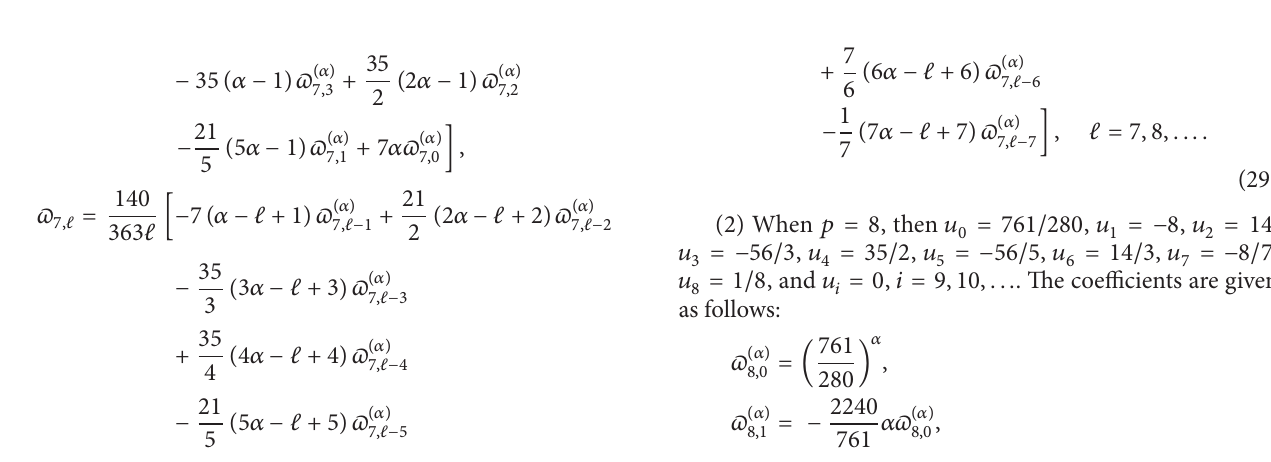
Figure 7: The values of the coefficients 𝜛 (𝛼) 9,ℓ (ℓ = 0,1,...) for 𝛼 = 0.3 .